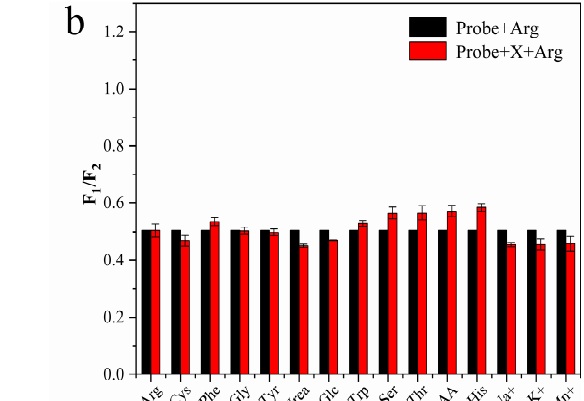
ratio of N-CD/calcein sensor on Arg detection with or without interference substances.